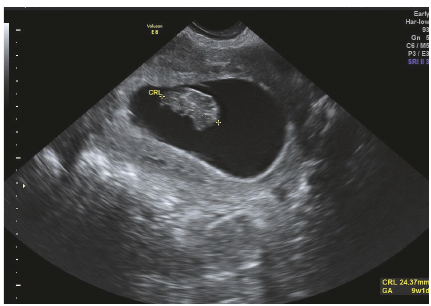
Figure 2: Intrauterine pregnancy demonstrated by transvaginal